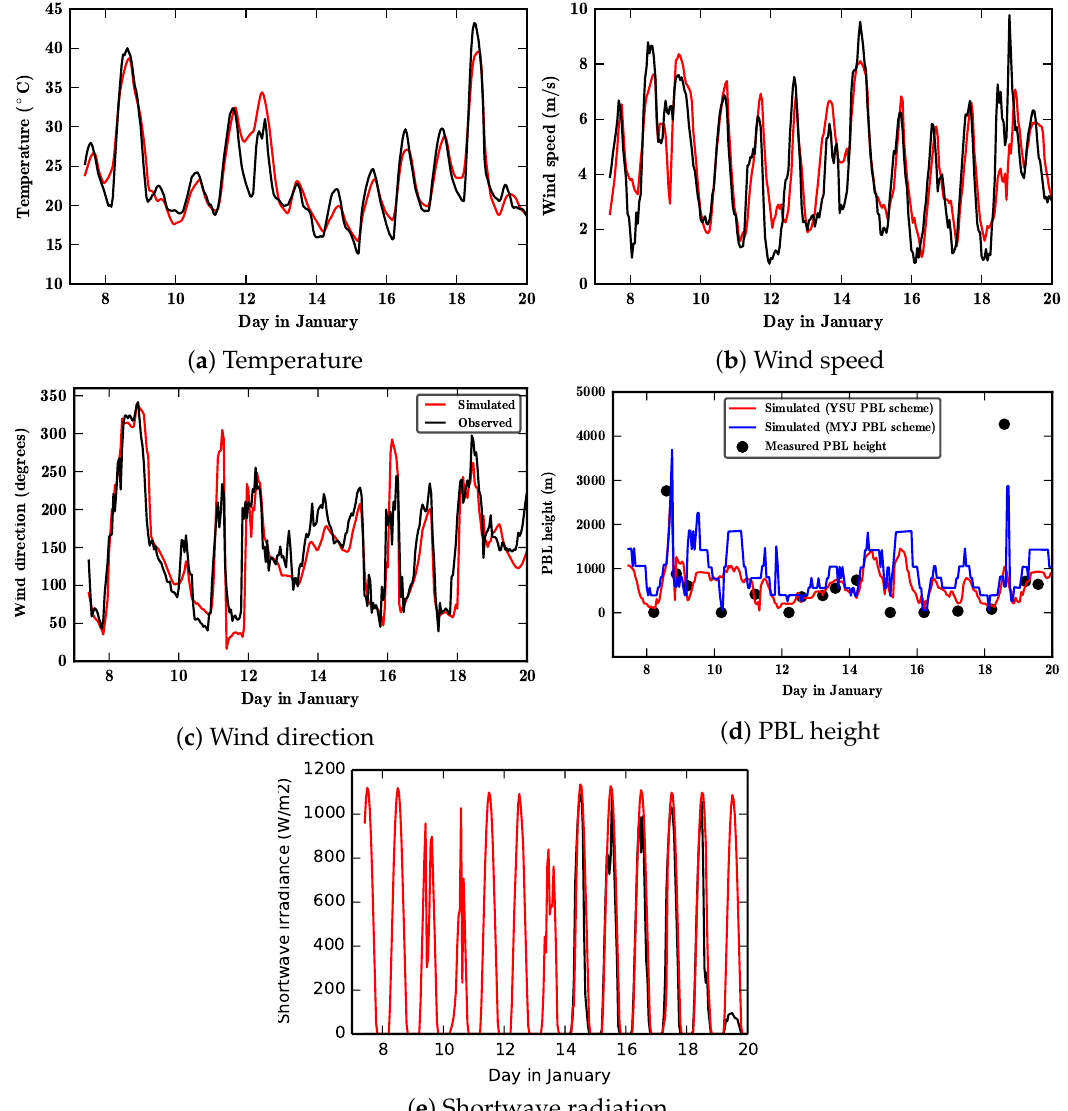
Figure 4. Observed (in black colour) and simulated (in red colour) meteorological variables, averaged over all measurement sites. For shortwave radiation, the data is provided for MUMBA site